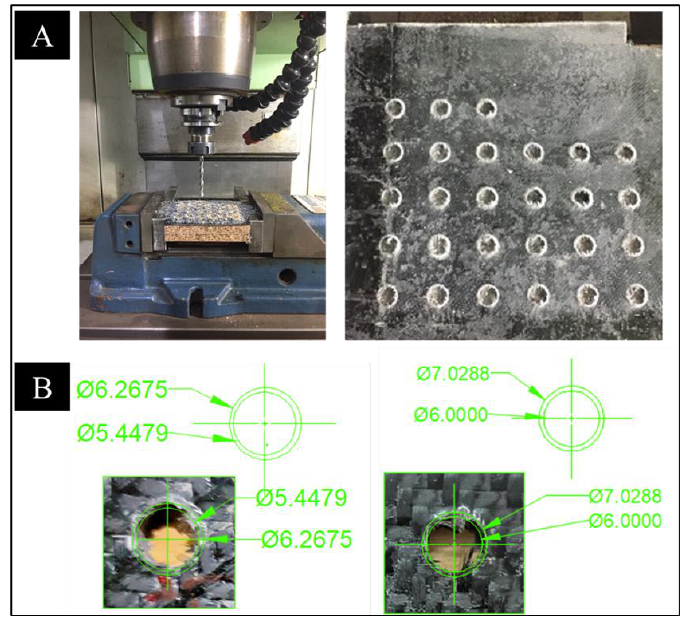
Figure 7. ( A ) Drilling operation of samples and images of drilled holes on the surface of the compo- site material; ( B ) Assessment of diameters D-Max and D-Min at the top and bottom,